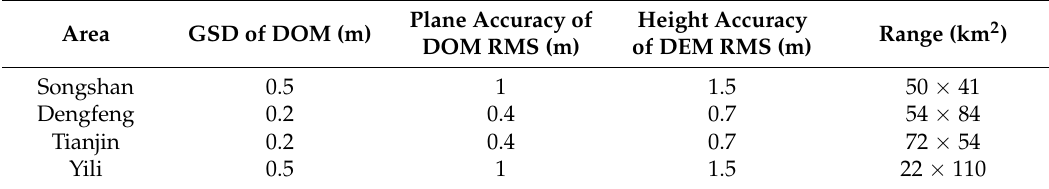
Table 3. Specific information about the reference data.